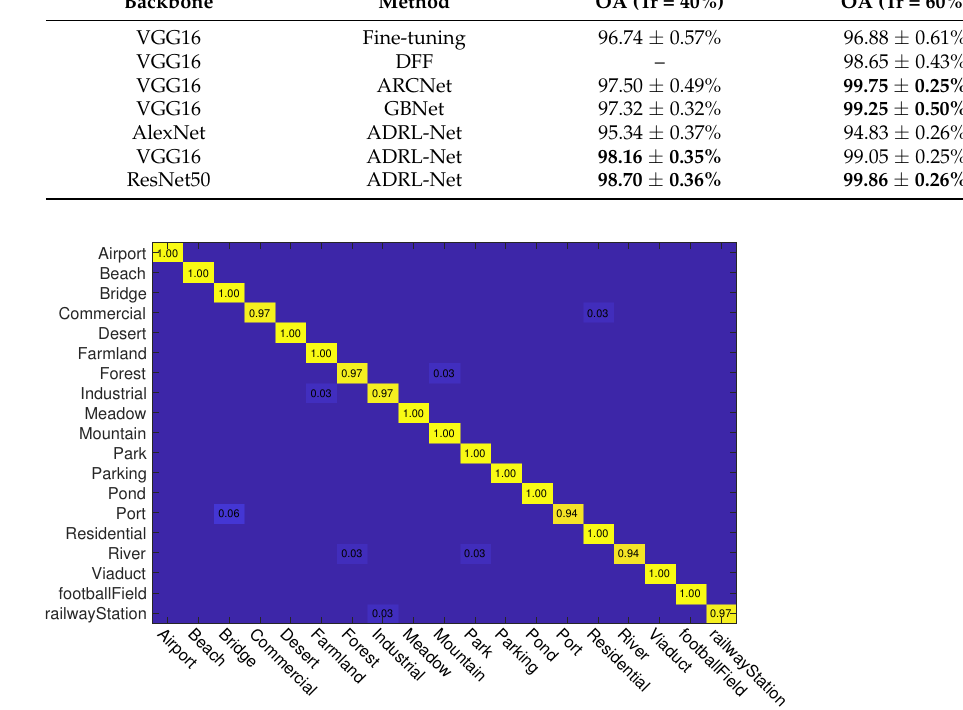
Figure 10. Confusion matrices obtained by ADRL-Net with ResNet50 as backbone on the WHU-RS19 dataset. Tr =